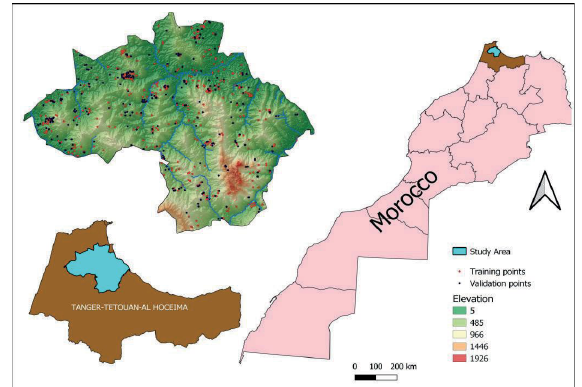
Figure. 1. Location of the study area and forest fire inventory points Tetouan Province belongs to a region with a Mediterranean climate, marked by the existence of two different seasons. The area generally records an annual cumulative rainfall exceeding 700 mm on average. As for the temperatures, they are influenced on one side, by the action of the Mediterranean Sea and the Atlantic Ocean, and on the other side, by the altitude and the winds, in particular Chergui. In general, temperatures vary between 5.3° in cold periods and 32.9° in hot periods (HCP, 2014). The region is mainly crossed by Oued Martil and Oued Laou whose flows vary between 15 and 70 l/s. It includes two dams, one of which is large, namely the Nakhla dam (HCP, 2014). Precipitation is the highest there and varies between 800 and 1,400 mm/year sometimes reaching 2,000 mm/year with snowfall. In the Tanger- Tetoun-Al Hociema region, forests cover an area of 506,442 ha, which represents 31.63% of the forest area of the region. Therefore, the study area covers a forest area of 86,360 ha, which represents 33.98% of the area of the Tetouan province (“Regional Directorate, 2018,”n.d.) (Table 1).